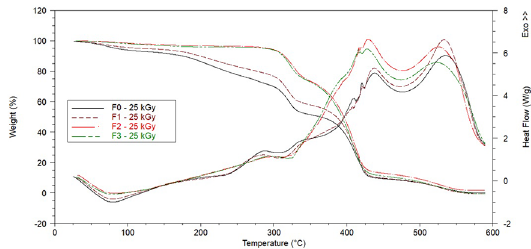
Figure 6. DSC curves of the irradiated 25 kGy